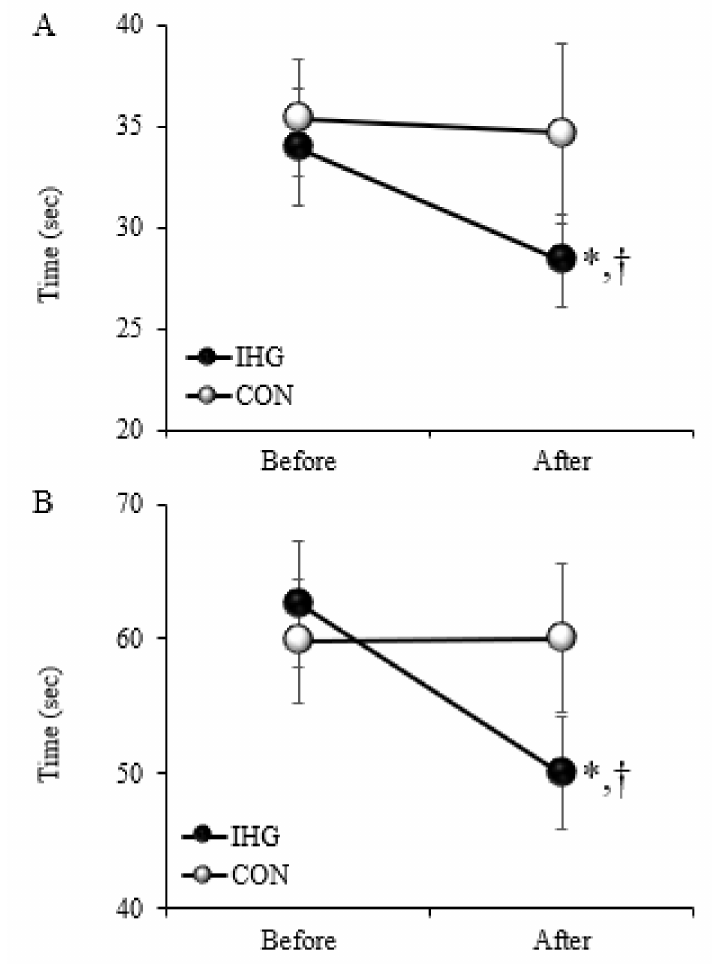
Figure 2. Changes in TMT-A ( A ) and TMT-B ( B ) before and after the exercise intervention in the IHG and CON groups. Values are mean ± SE; TMT, trail-making test; IHG, isometric handgrip; CON, control; *, significant difference ( p < 0.05) from before; †, significant difference ( p < 0.05) from the CON